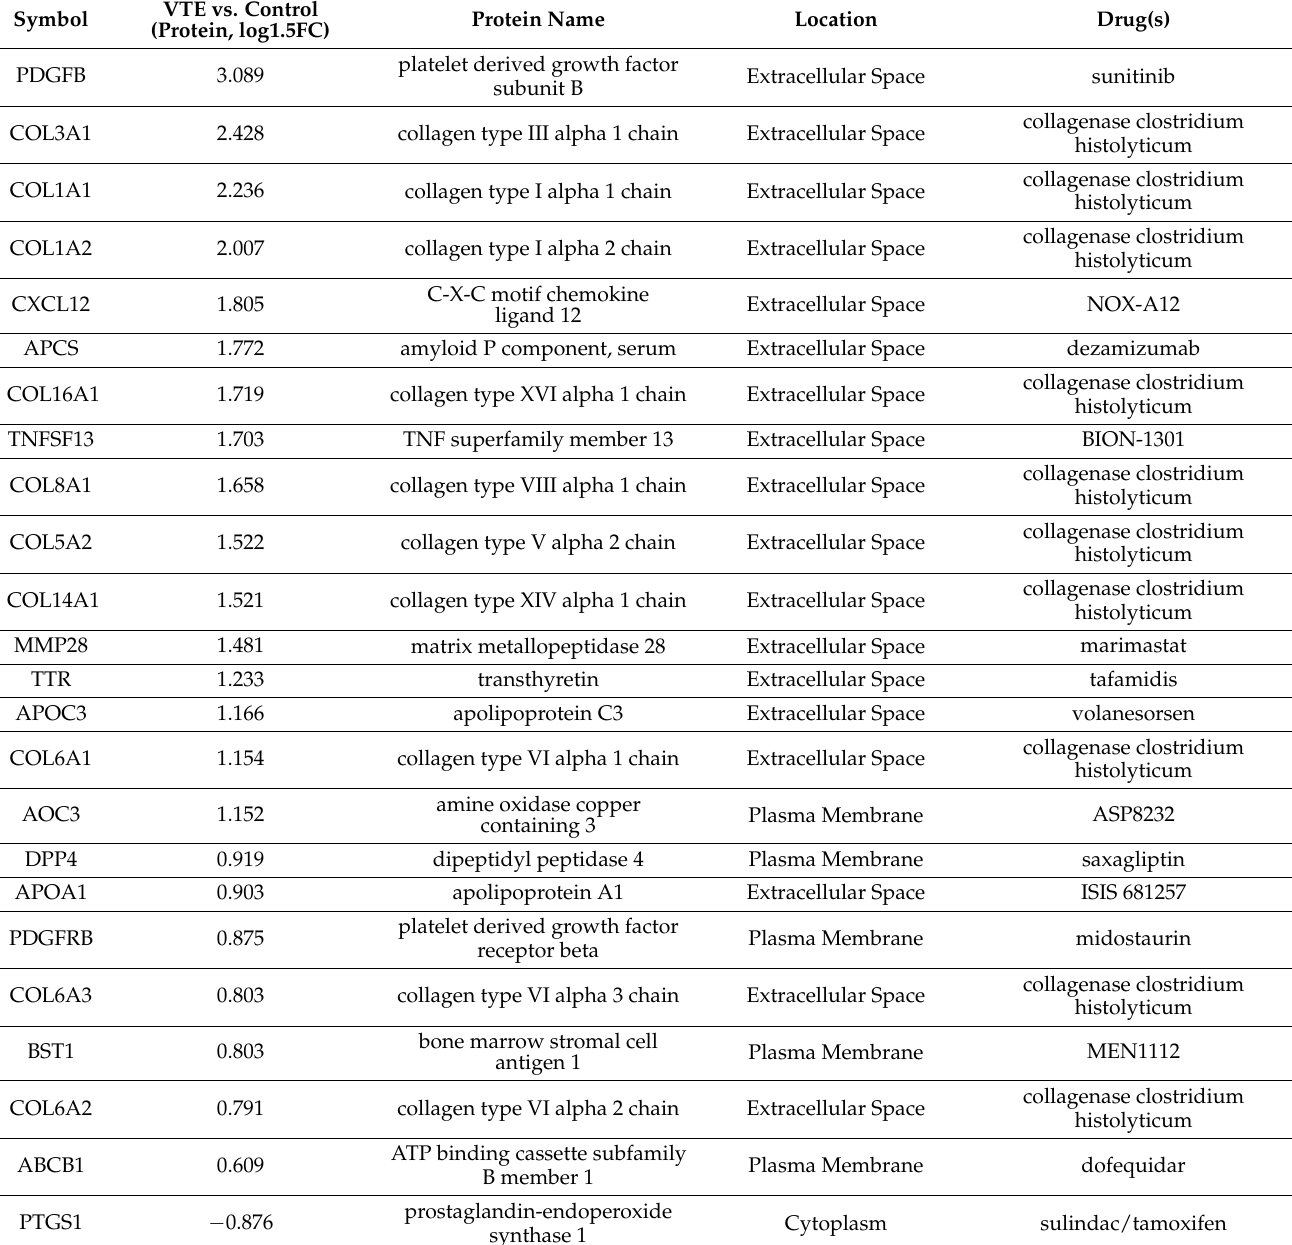
Table 2. Putative drug targets significantly altered in the VTE vs. control groups